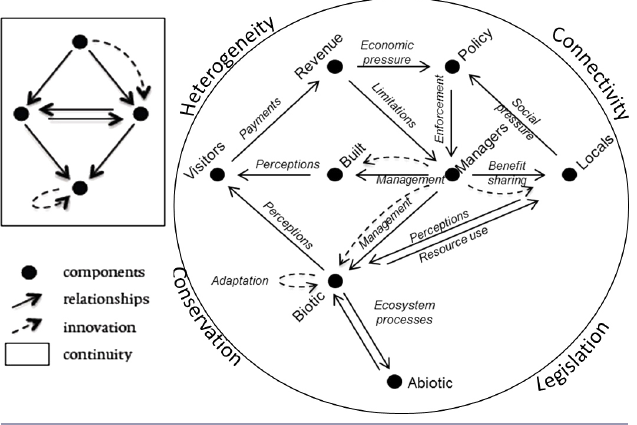
Fig. 1 . Conceptual diagram of identity elements of protected areas in healthy systems. Perturbations such as wildlife disease ripple through the system via the various